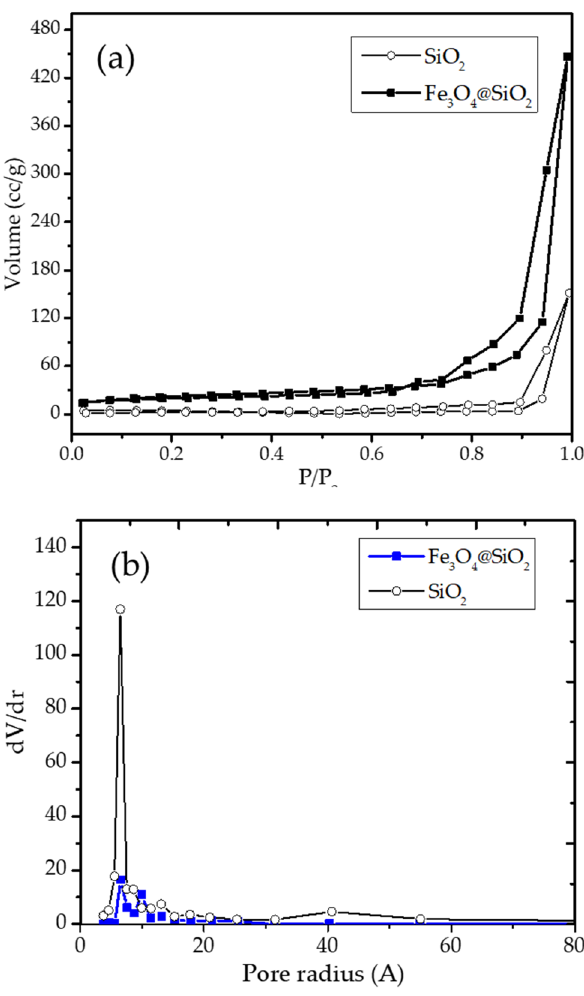
Figure 5: ( a ) Adsorption – desorption pro fi le; ( b ) pore distribution of Fe 3 O 4 @SiO 2 in comparison with SiO 2 .